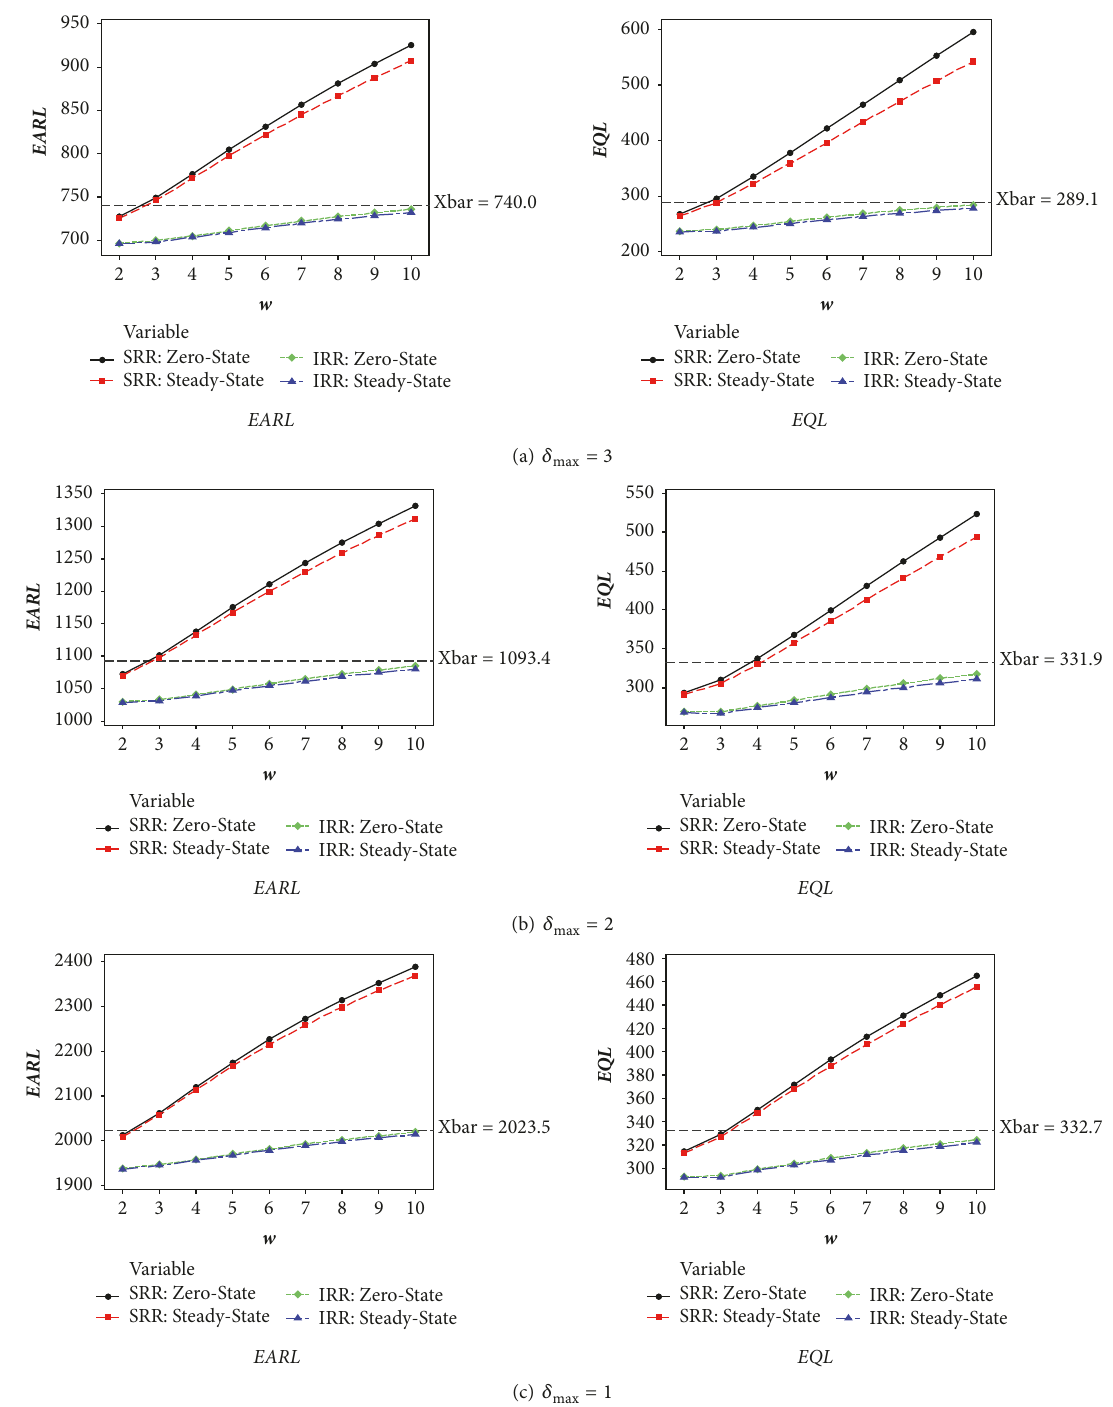
Figure 3: The zero-state and steady-state EARL and EQL values (with 𝛿 min = 0 ) of the two-sided non-side-sensitive SRR and IRR schemes when ARL 0 =